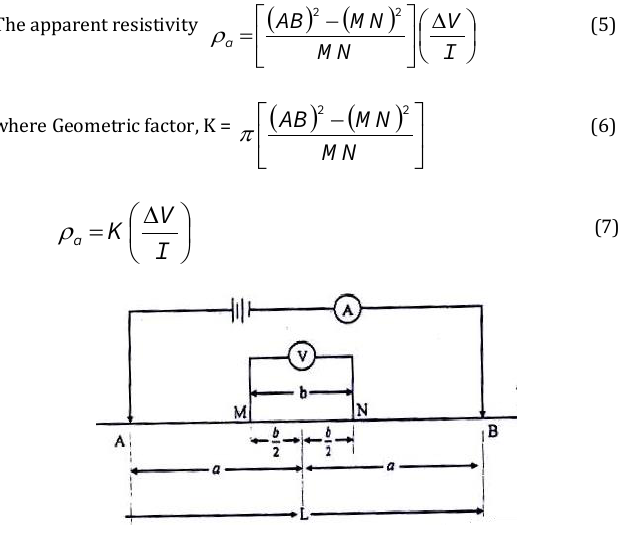
Figure 2 : Schematic Diagram of Schlumberger